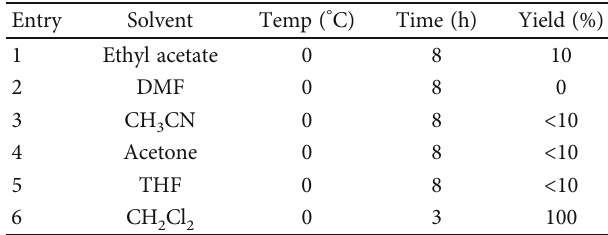
Scheme 1: Synthetic pathway for the target compounds. Table 1: E ff ect of di ff erent reaction condition on the yields of intermediate C.